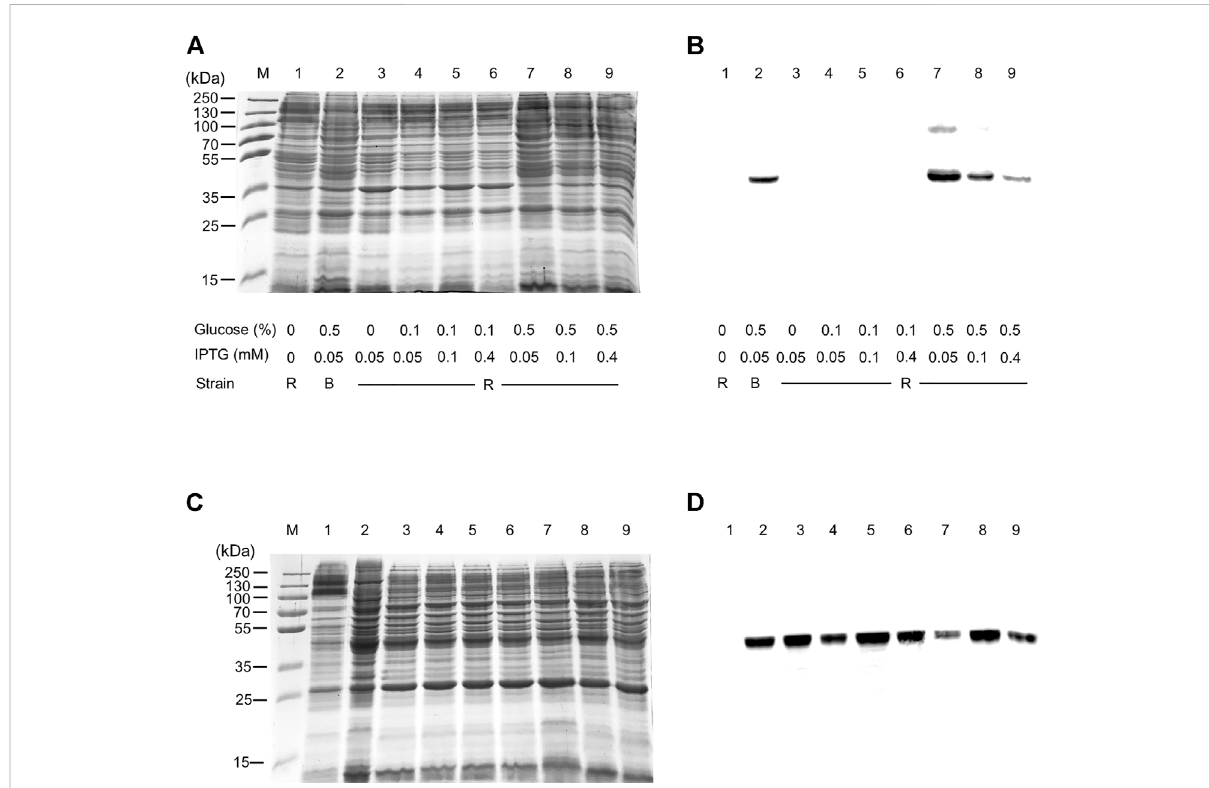
FIGURE 2 hxCT expression: the effect of strain, medium, and oxygen. E. coli BL21 codon plus or Rosetta (DE3)strain was transformed with hxCT-pH6EX3 construct and cultured in the absence or presence of different glucose and IPTG concentrations. (A) SDS-PAGE of insoluble fractions after 8 h of growth from:1,uninducedcelllysate;2 – 9inducedcelllysatesindifferentconditions:IPTGandglucoseconcentrationareindicatedinthe fi gure; M, page ruler prestained plusmarker;R, Rosetta (DE3); B, BL21 codon plus. (B) Western blotting using anti His antibody of thesamples loaded as in (A) . (C) SDS-PAGEofinsolublefractionsofRosettacellsafter8 hofgrowthfrom:1,uninducedlysate;2 – 9,inpresenceof0.5%glucoseand0.05 mM IPTG.Inparticular,lanes 2and 3,from 25 mlof LBand Terri fi cbroth,respectively, cultured ina250 mlErlenmeyer open fl ask; lane4:sample treated asinlane3butinpresenceofplug;lanes5 – 7,from100,200,and300 mlofTerri fi cbroth,respectively, culturedina1 LErlenmeyeropen fl ask;lanes 8and9,from200 mlofTerri fi cbrothcultured ina2 Lopenand closedErlenmeyer fl ask,respectively. (D) WesternblottingusingantiHisantibodyof the samples loaded as in (C)